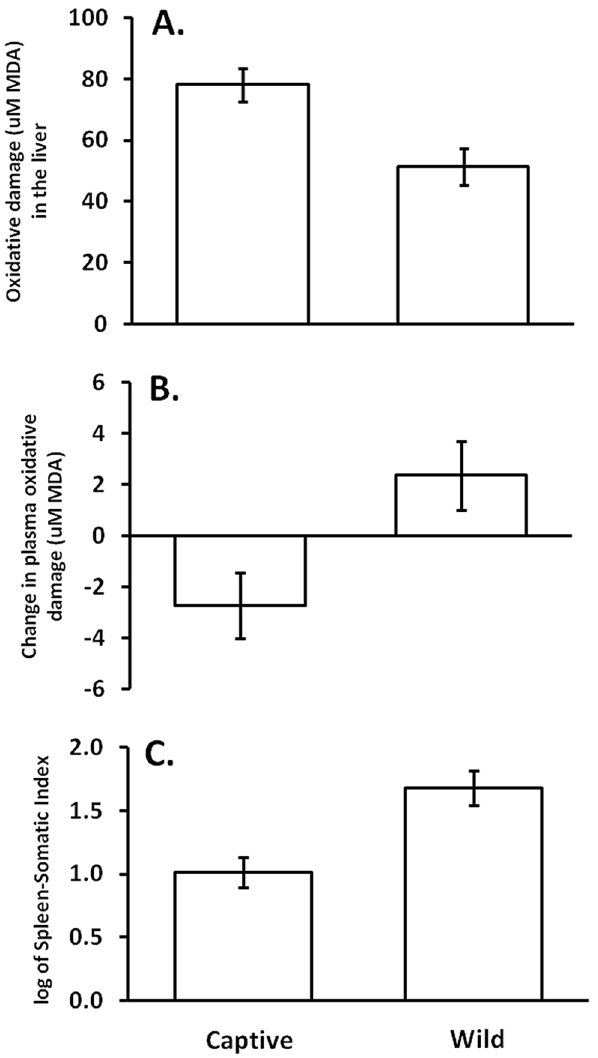
Fig 1. Differences between wild and captive-raised chameleons. Chameleons that were raised in captivity had (A) larger amounts of oxidative damage in the liver, but (B) reduced the circulating amount of oxidative damage in plasma over the 48-hour time period relative to wild chameleons, regardless of treatment. Captive-bred chameleons also had (C) relatively smaller spleens. LSMeans are shown, ± standard